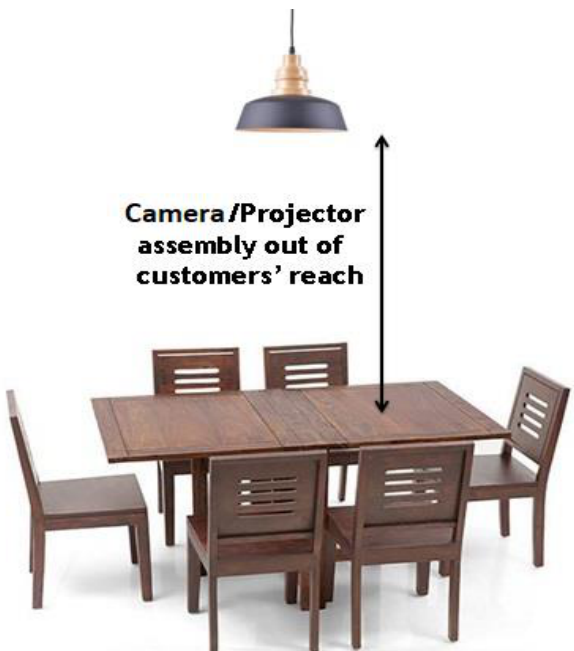
Fig. 4. Camera and projector holders